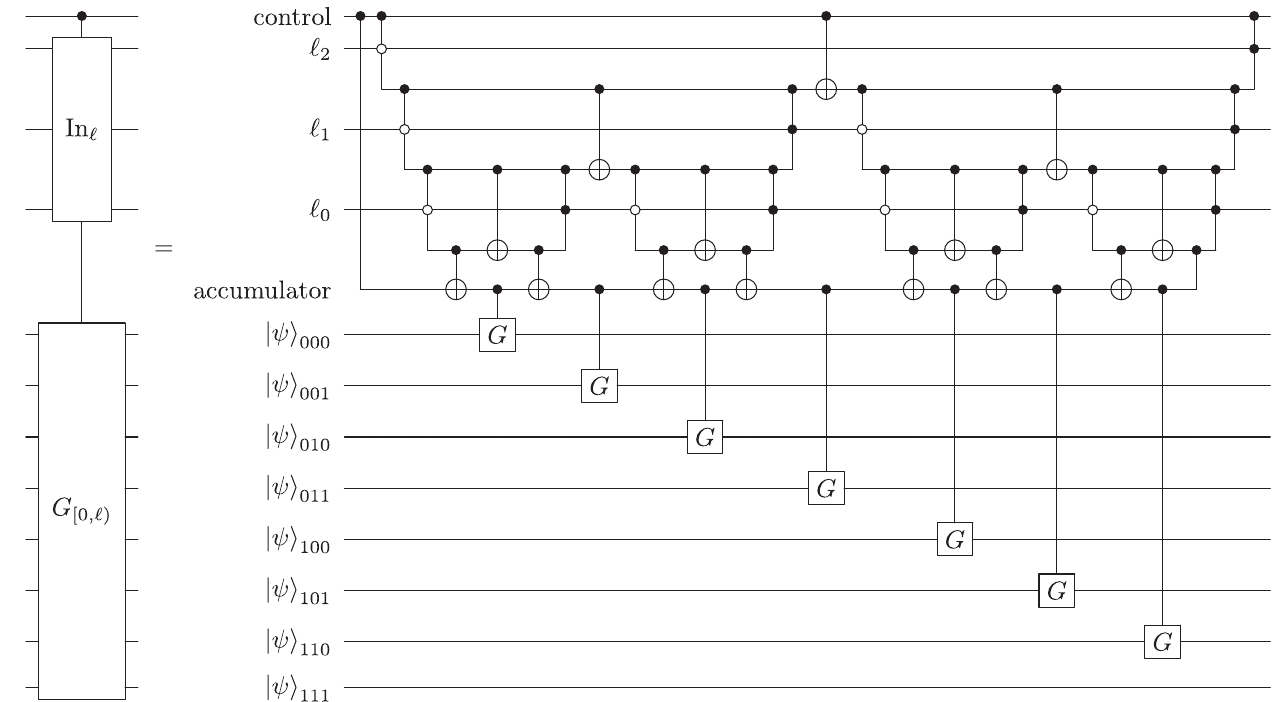
Q l − 1 ψ i . It applies the G operation to a range of values, instead G k j k ¼ 0